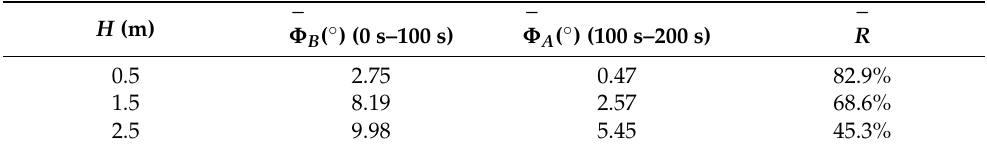
Table 5. Anti-roll parameters of the